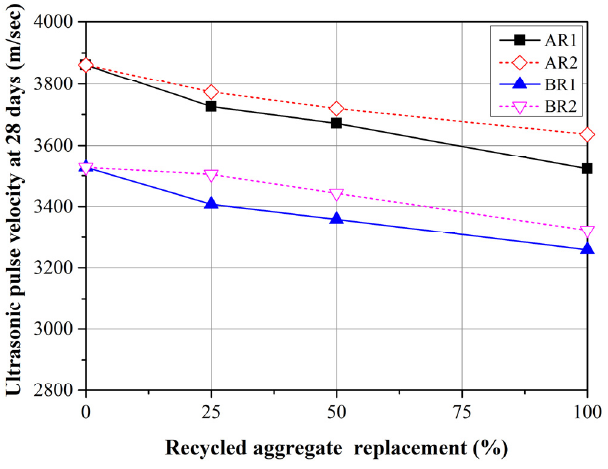
Figure 10. UPV values of mortars with R1 and R2 replacement at 28